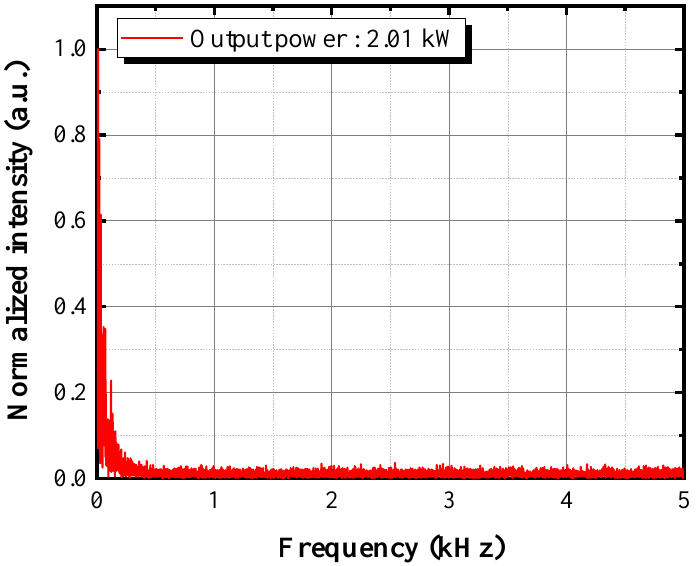
Figure 5. Power stability of the output beam at the maximum output power. To prove the performance of the proposed PRBS technique, we also measured the output characteristics of the amplified seed laser using conventional PRBS phase modu- lation at 8 GHz, as shown in Figure 6. The PRBS modulation frequency of 8 GHz with a band pass filter of 4.4 GHz and n = 9 pattern allowed power scaling of the output to 1.63 kW. The applied electrical signal of PRBS signal is shown in Figure 2d. The amplified output power and backward scattered power were measured as a function of the pump